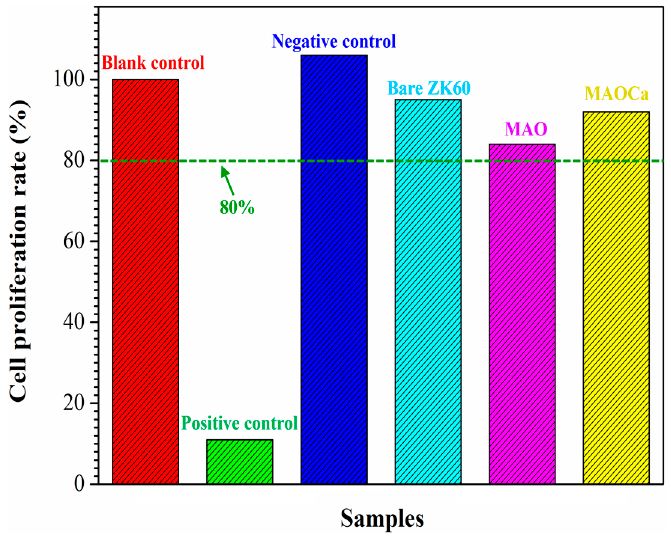
Figure 11. Results of in vitro cytotoxicity test. MTT assays of three cell cultures with the control species, bare ZK60, the MAO-coated and the MAOCa-coated specimens after 24 h immersion in the medium.